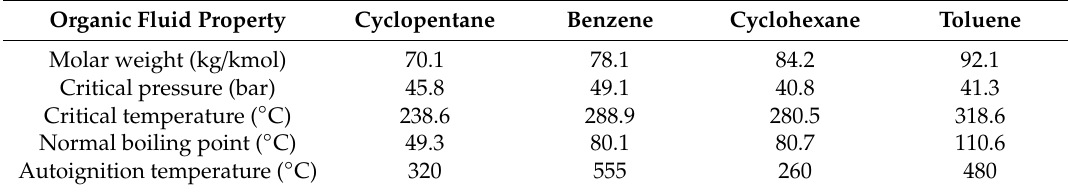
Table 2. Main properties of selected organic fluids